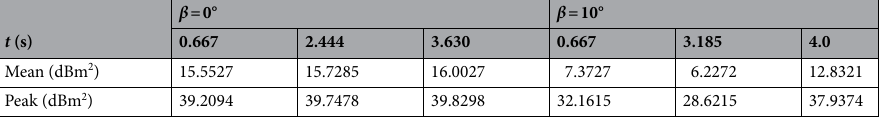
Table 4. RCS indicator of the aircraft in Z1 mode, α = 0° ~ 360°, f RH = 6 GHz, ω r1 = ω r2 = 0.3142 rad/s, A m1 = A m2 = 0°.